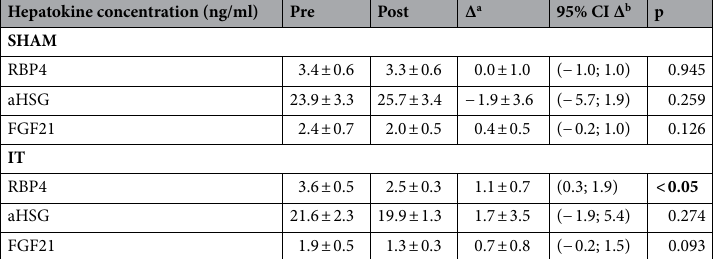
Hepatokine concentration (ng/ml) Pre Post Δ a